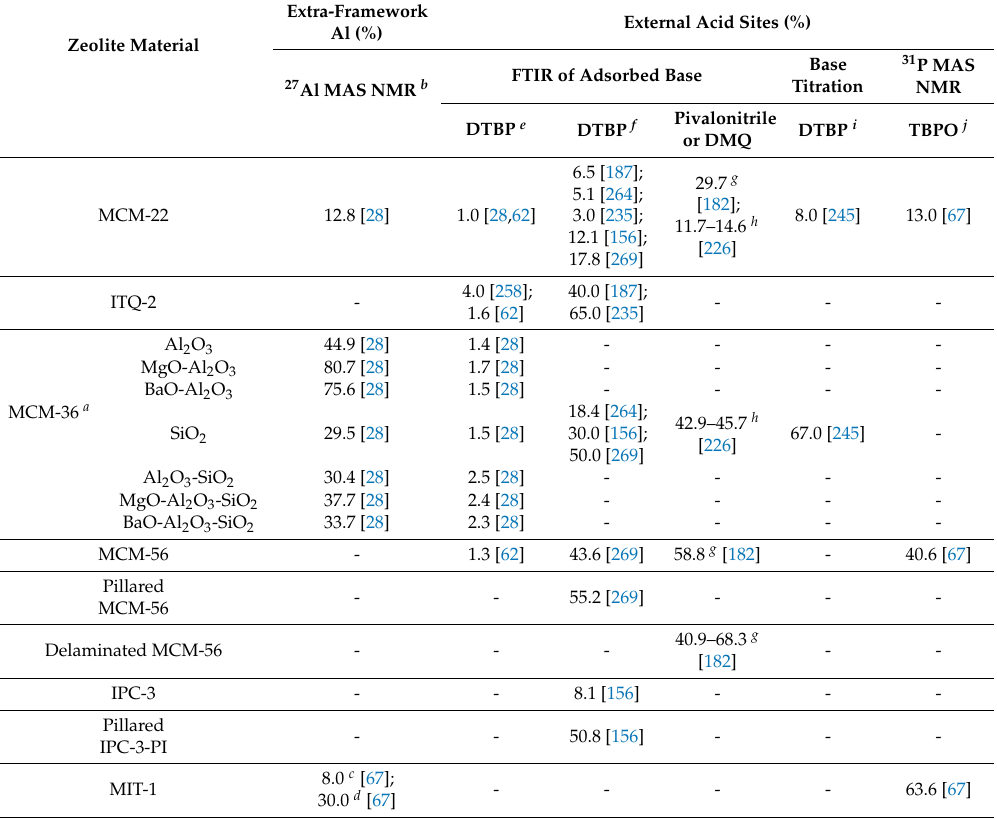
Table 13. Selected literature values of extra-framework Al and external acid sites in 2D MWW zeolite probed by di ff erent